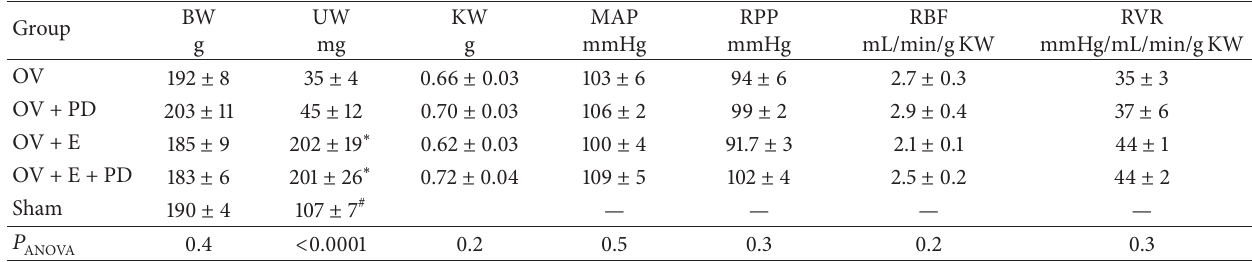
Table 1: Hemodynamic variables before vehicle or PD123319 administration and body, uterus, and kidney weights at postmortem.